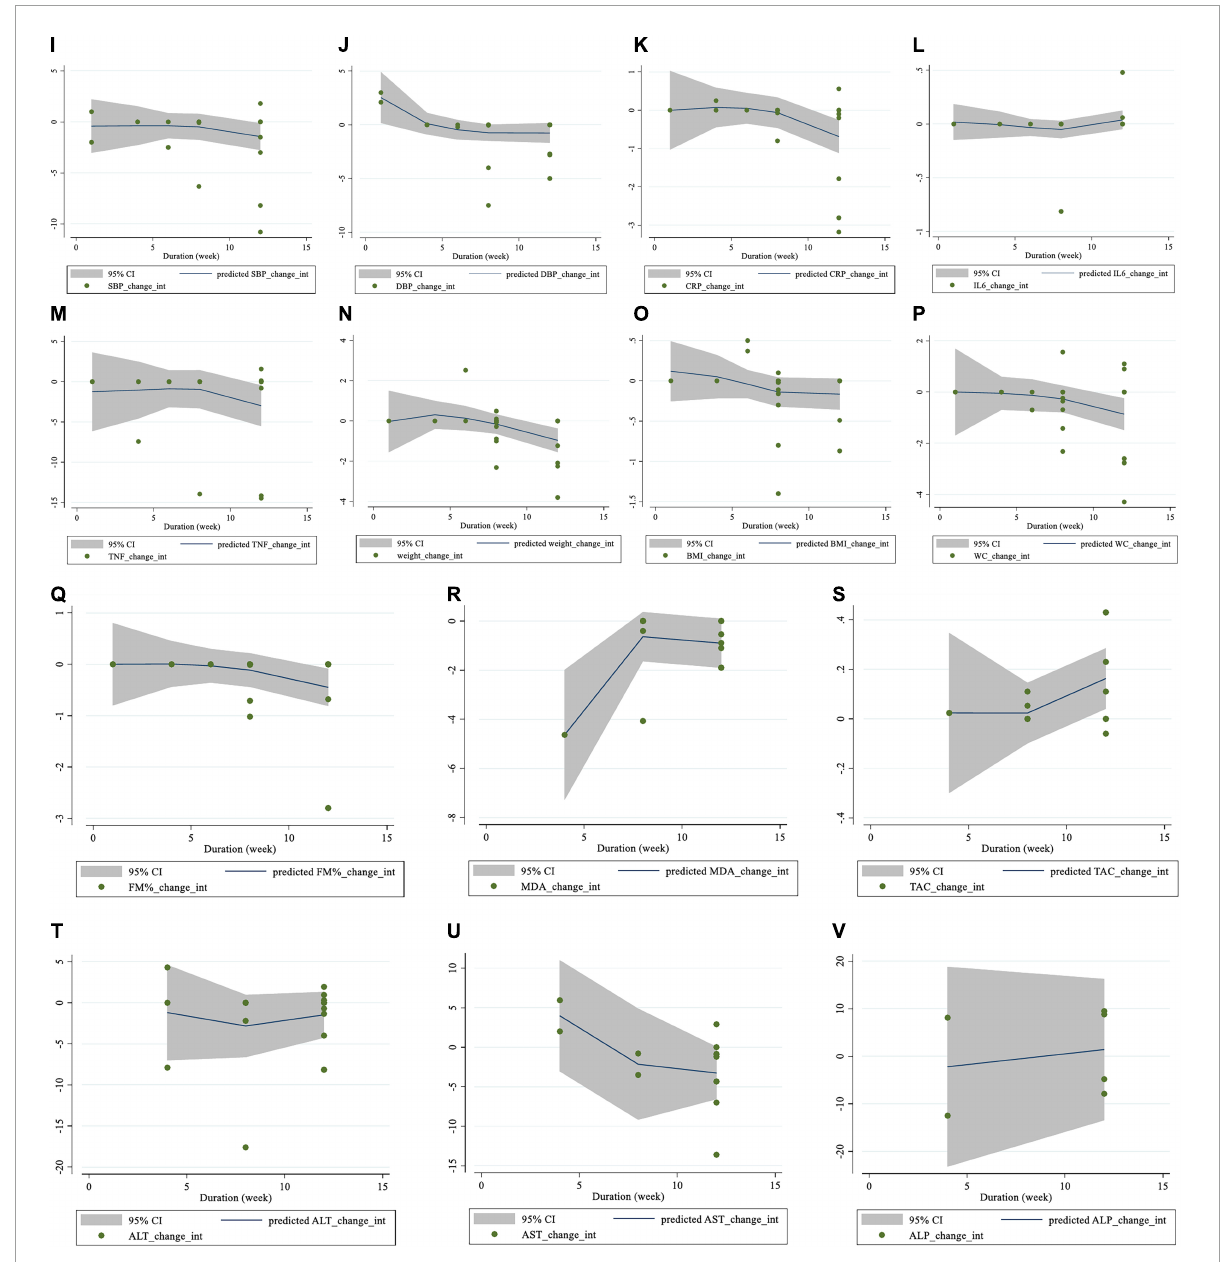
FIGURE5 Non-linear dose-response relations between saffron consumption and absolute mean differences. Dose-response relations between duration of intervention (week) and absolute mean differences on (A) TG (mg/dl); (B) TC (mg/dl); (C) LDL (mg/dl); (D) HDL (mg/dl); (E) FBG (mg/dl); (F) Insulin (miu/ml); (G) HbA1c (%); (H) HOMA-IR; (I) SBP (mmHg); (J) DBP (mmHg); (K) CRP (mg/l); (L) ; IL-6 (pg/ml); (M) TNF- α (pg/ml); (N) weight (kg); (O) BMI (kg/m 2 ); (P) WC (cm); (Q) FM (%); (R) MDA (uM/L); (S) TAC (mM/L); (T) ALT (U/L); (U) AST (U/L) and (V) ALP (U/L). TG, triglyceride; TC, total cholesterol; LDL, low-density lipoprotein; HDL, high-density lipoprotein; FBG, fasting blood glucose; HOMA-IR, homeostasis model assessment for insulin resistance; HbA1C, hemoglobin A1C; CRP, C-reactive protein; IL-6, interleukin 6; TNF- α , tumor necrosis factor; TAC, total antioxidant capacity; BMI, body mass index; WC, waist circumference; FM, fat mass; ALT, alanine transaminase; AST, aspartate transaminase; ALP, alkaline phosphatase; MDA, malondialdehyde ; SBP, systolic blood pressure; DBP, diastolic blood pressure; CI, confidence interval; WMD, weighted mean